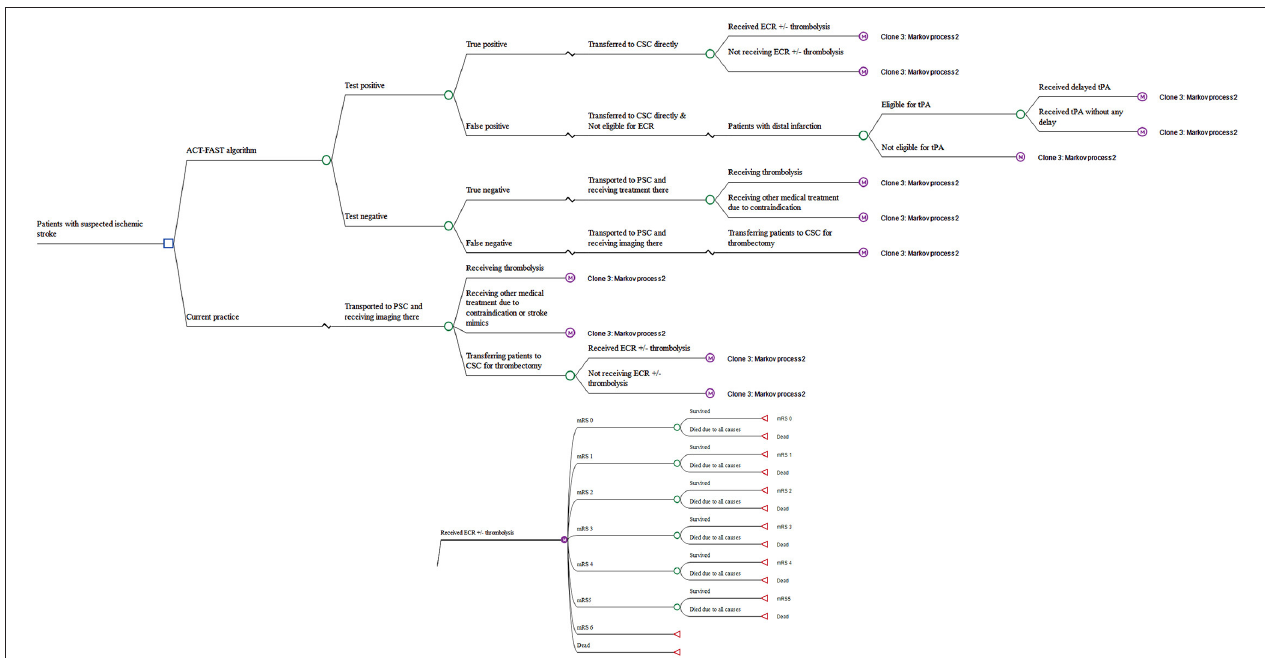
FIGURE 1 | Model structure for the long-term cost-effectiveness analysis. ACT-FAST, Ambulance Clinical Triage for Acute Stroke Treatment; PSC, primary stroke center; CSC, comprehensive stroke center; ECR, endovascular clot retrieval; tPA, tissue plasminogen activator; mRS, modified Rankin